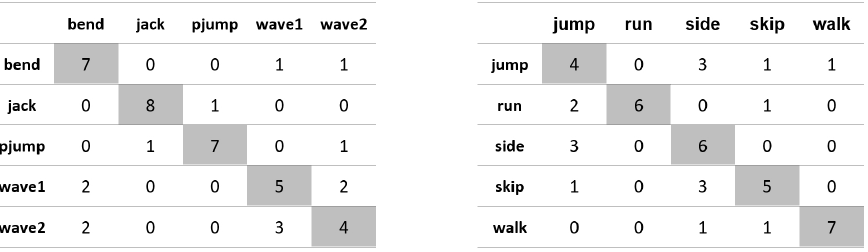
Figure A6. Confusion matrices for the experiment using the ‘lower-occlusion’ database, MBR area and Euclidean distance.